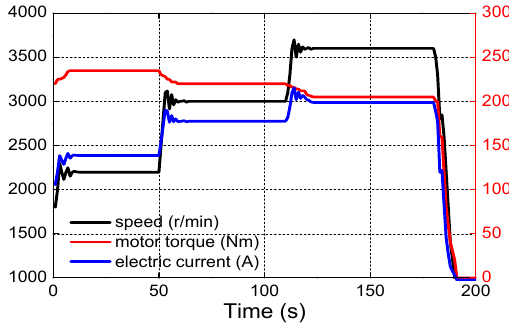
Figure 22. Test of power generation with the power generation system.